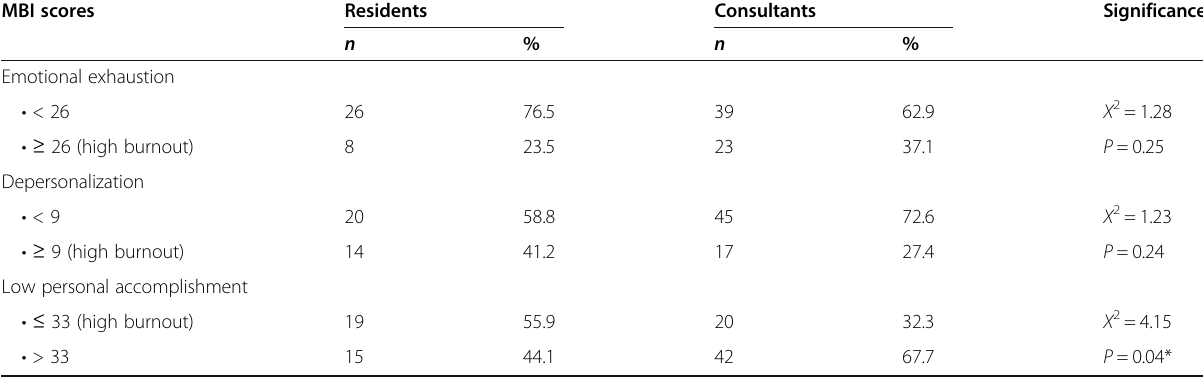
Table 1 Participants ’ distribution according to Maslach Burnout Inventory – Human Services Survey score MBI